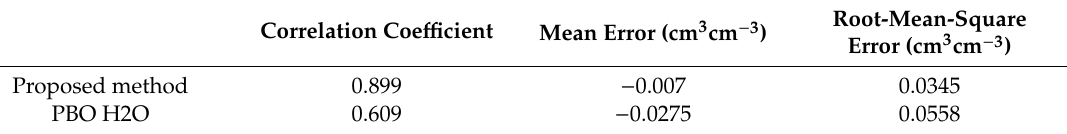
Figure 9. Soil moisture estimation errors of proposed method and PBO H2O. Table 1. Soil moisture estimation precision statistics